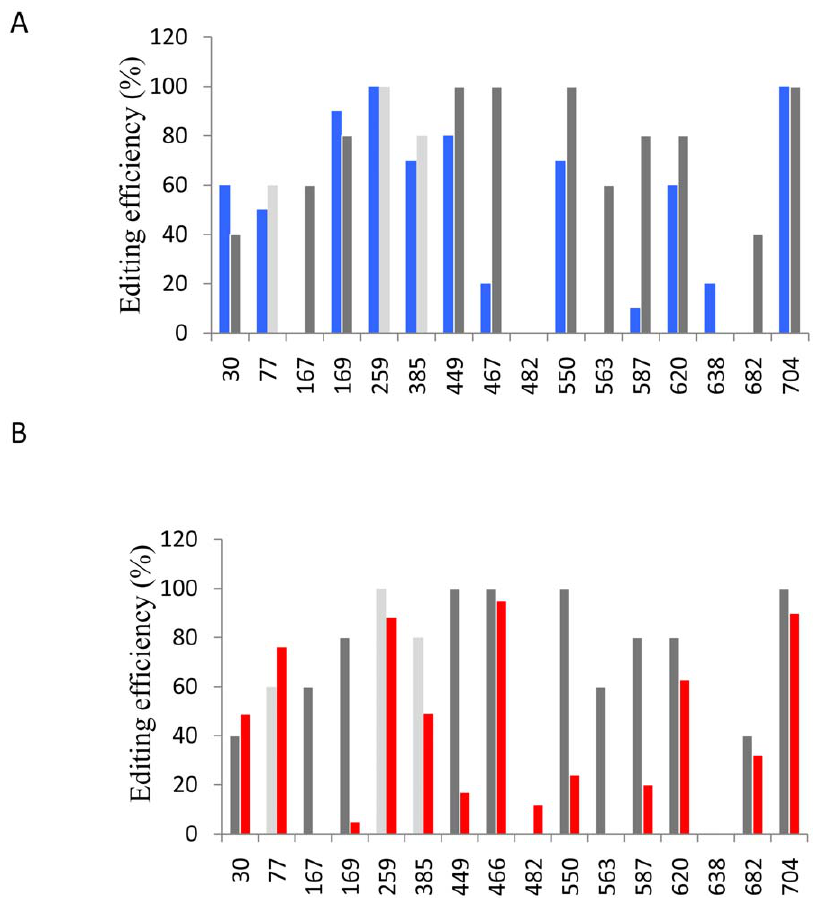
Figure 2. Editing status of cox2 transcripts carrying combined 2 1 or + 1 mutations. Gray bars represent the editing efficiency on the wild type transcripts. (A) Editing status of mRNA from the combined 2 1 mutant (blue bars). (B) Editing status of mRNA from the combined + 1 mutant (red bars). The sites C77, C259 and C385 not mutated in the 2 1 or + 1 combined constructs are shown by light gray bars. The results presented are representative from at least two separate experiments. Editing efficiency variations in replicates was lower than